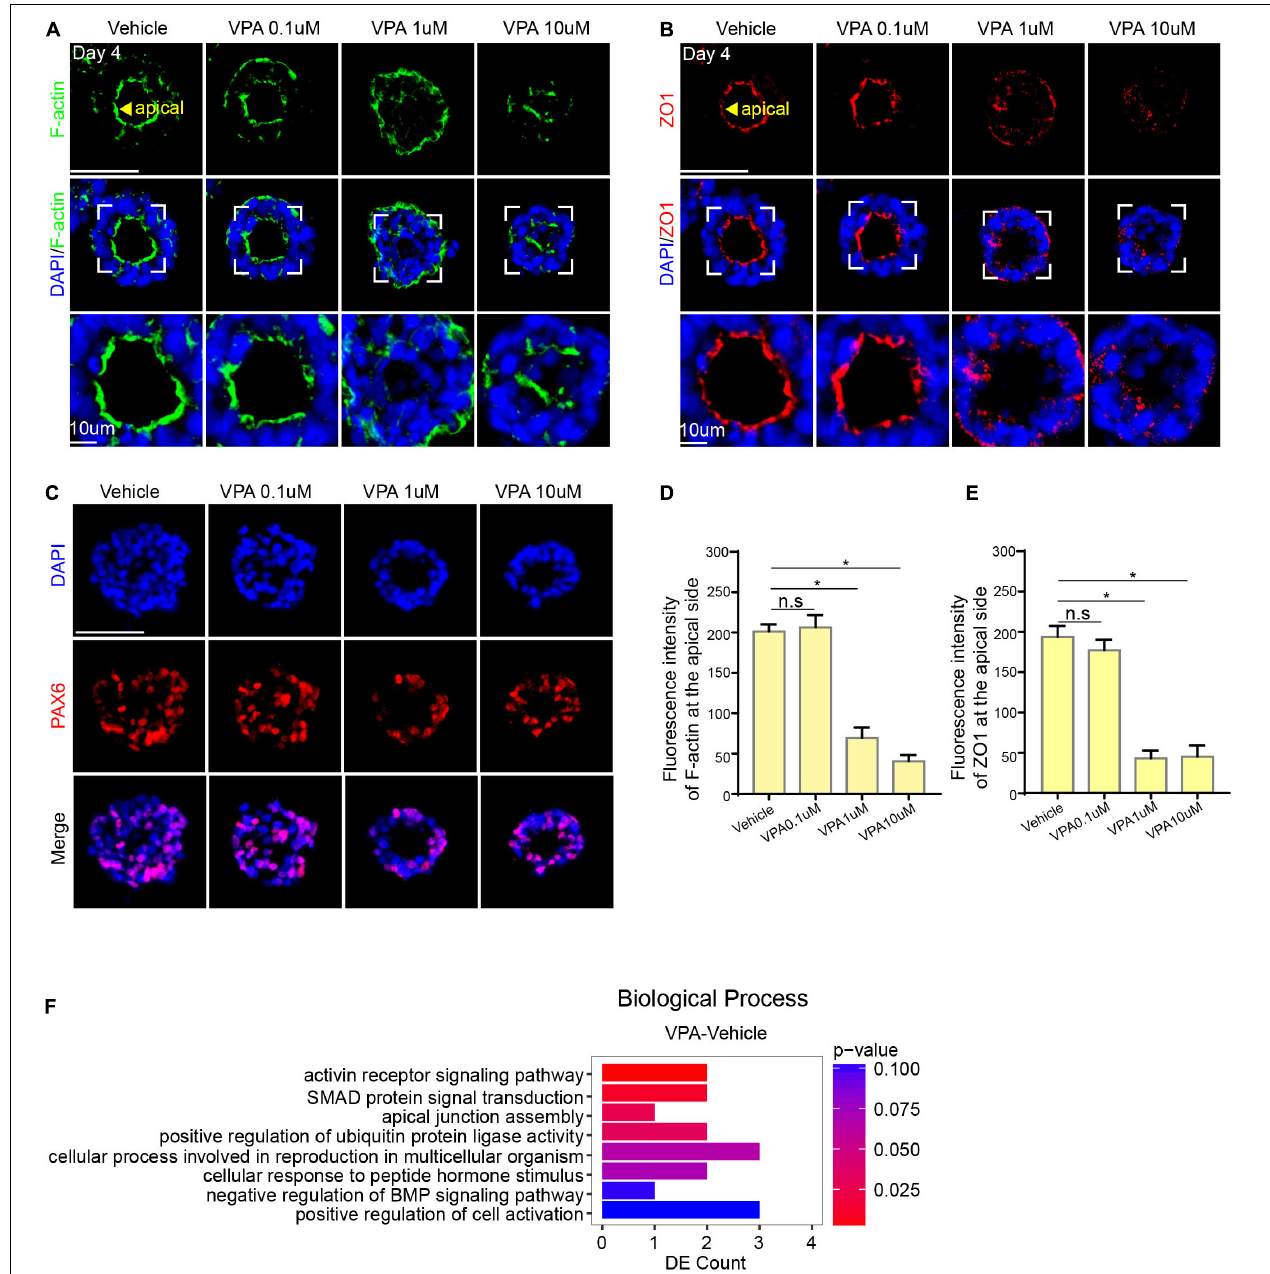
FIGURE 5 | VPA-induced morphogenesis inhibition on neural tube model. (A,D) The expression of F-actin at the apical domain in control, 0.1, 1, and 10 µ M group. (C) The expression of PAX6 in control, 0.1, 1, and 10 µ M group. (B,E) The expression of ZO-1 at the apical domain in control, 0.1, 1, and 10 µ M group. (F) RNA sequencing of VPA1 µ M and control group. Scale bars: 50 µ m. * P <